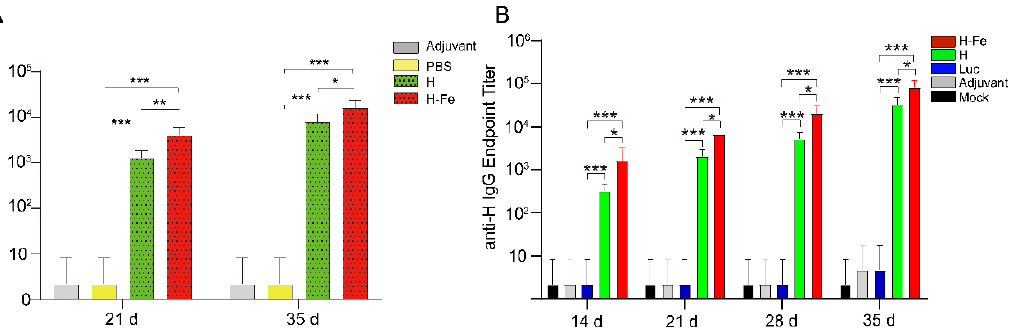
Figure 5. The detection of serum antibody titers of immunized mice in each group. ( A ) Antibody titer induced by antigen prepared by E. coli expression system in mice. Adjuvant: single-adjuvant immunization group; PBS: PBS injection group; H: H protein expressed in E. coli mixed-adjuvant immunization group; H-Fe: H-Fe protein expressed in E. coli mixed-adjuvant immunization group. ( B ) Antibody titer induced by antigen prepared by silkworm baculovirus expression system in mice. Adjuvant: single-adjuvant immunization group; Luc: Luc immune group; H: H protein expressed in silkworm mixed-adjuvant immunization group; H-Fe: H-Fe protein expressed in silkworm mixed-adjuvant immunization group. In the figure, ‘*’ indicates p < 0.05, ‘**’ indicates p < 0.01, and ‘***’ indicates p < 0.001.